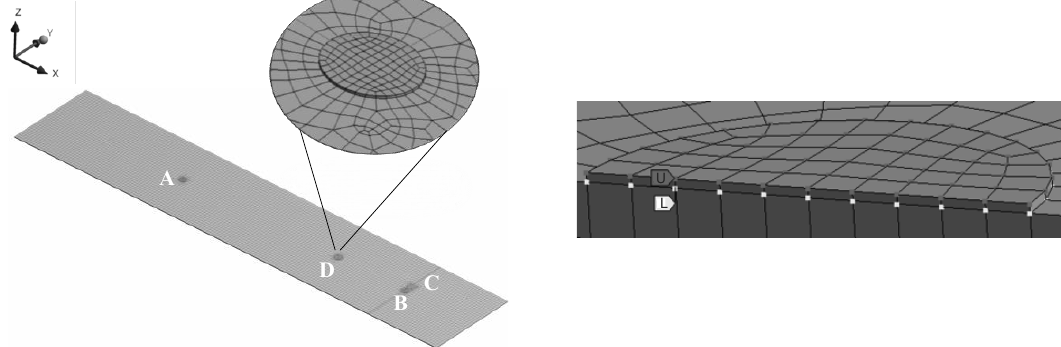
Figure 5. Meshing of plate and sensor ( left ) and Section on Plane XZ of Sensor Model ( right ). Ansys allows using several elements to model cases of changing mechanical contact between parts of an assembly or between different faces of a single part. The CONTA174 elements were used to mesh the contact between PZT sensors and